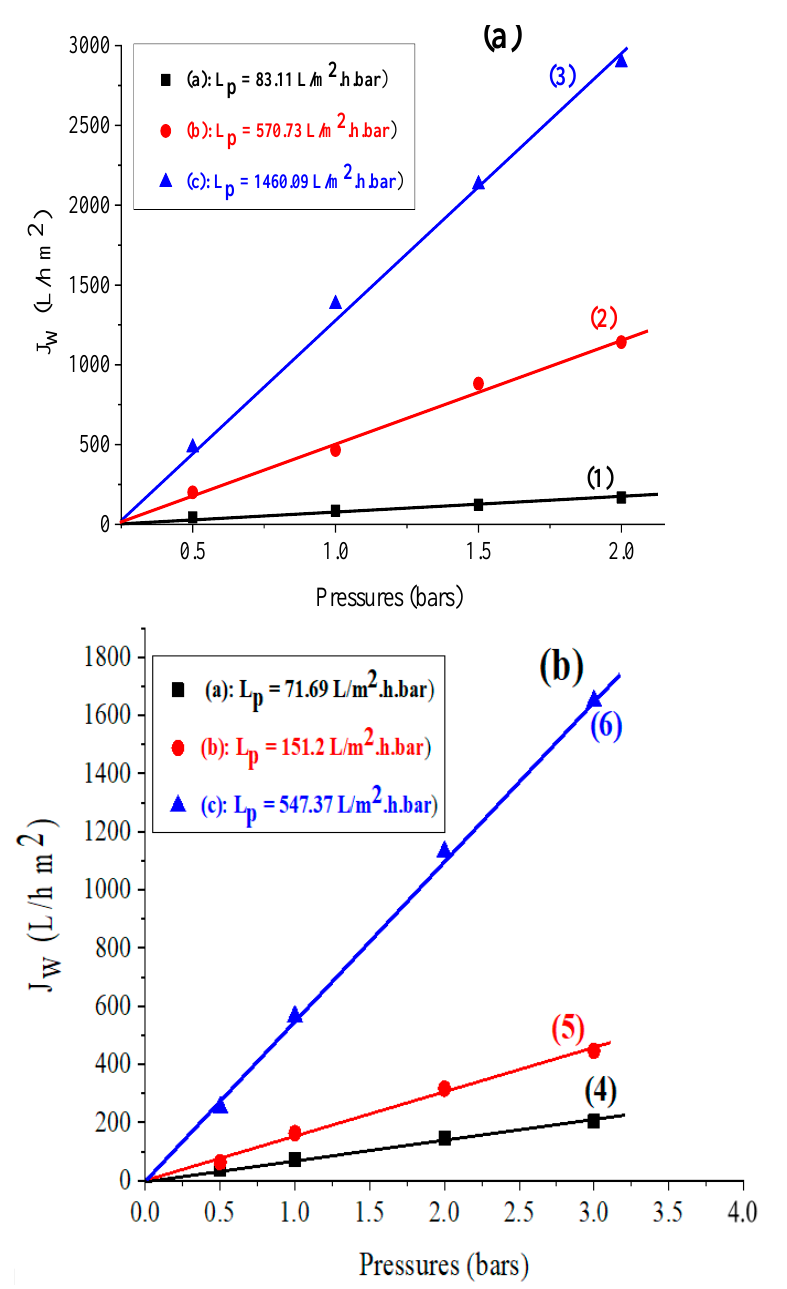
Figure 3. ( a ) Variation of the flux as a function of the applied pressure for the support based on (1) bentonite, (2) Aomar clay, (3) kaolin, and for the membranes developed based on ( b ) (4) bentonite, (5) Aomar clay and (6)